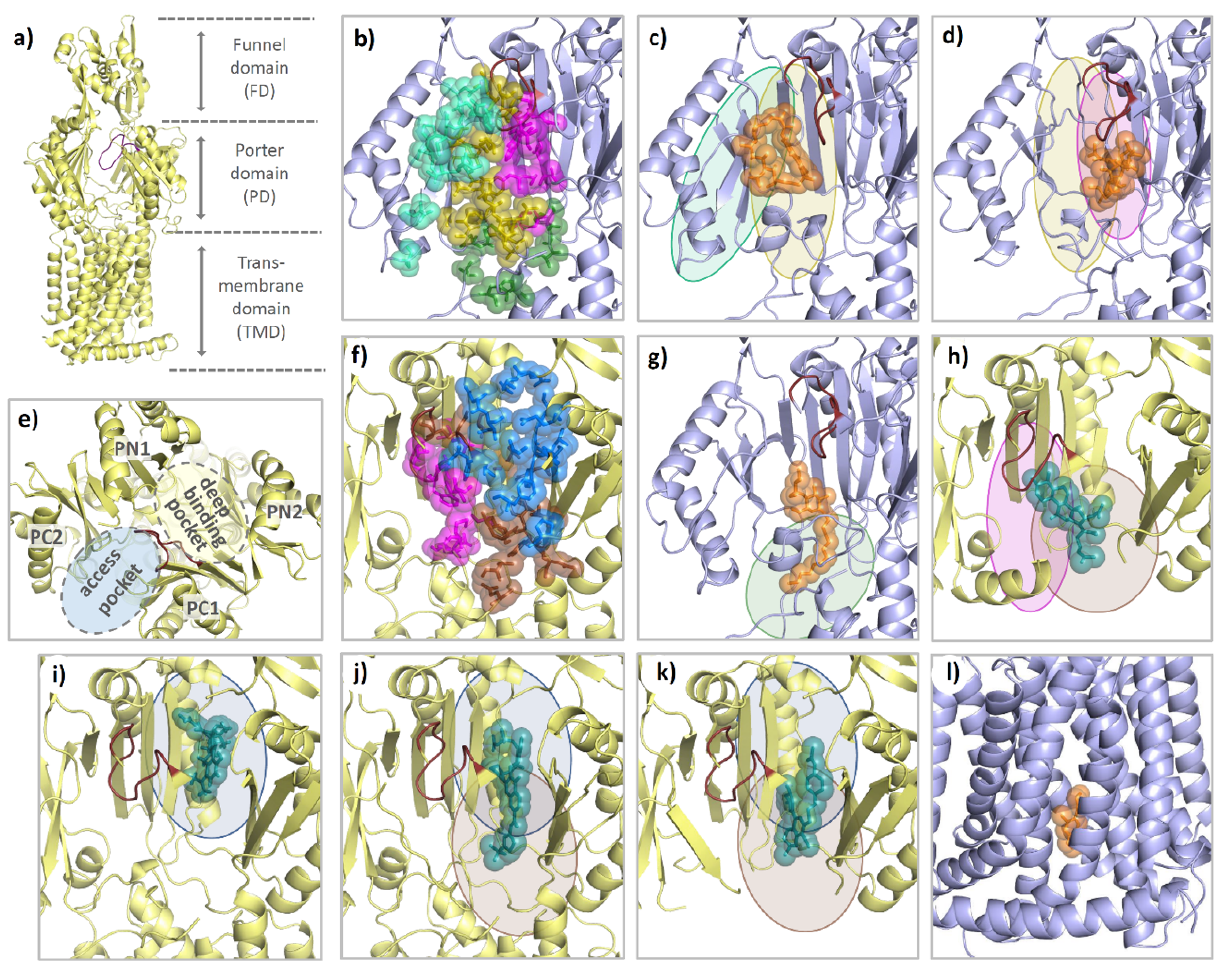
Figure 14. Comparison of the binding modes of AcrB substrates and inhibitors. Each AcrB protomer consists of a funnel domain (FD), a porter domain (PD), and a transmembrane domain (TMD) ( a ). The conformational states loose (L) and tight (T) are indicated by the color of the cartoon representation (light blue and yellow). As can be seen from a top perspective ( e ), the PD of the T protomer contains an access pocket (AP) and a deep binding pocket (DBP) that are separated by the switch loop (ruby). For the L protomer, all residues within 3.5 Å of a ligand are shown as colored spheres from a side perspective through the (removed) PC1 subdomain. Binding residues are grouped into an outer AP (cyan), an inner AP (olive), an AP–DBP interface (magenta), and channel 1 (CH1) (green) ( b ). As highlighted with the colors of the respective binding areas, the 3-formyl-rifamycin molecule (6ZOB) (shown as orange spheres, ( c )), which is stalled in front of the switch loop, predominantly binds to the outer and inner AP. Erythromycin (3AOC) ( d ), which is located underneath the switch loop, is in close contact with the inner AP and the AP-DBP interface. DDM (6ZOA) was found in CH1 of an L/T intermediate ( g ). Main residues involved in T protomer substrate/inhibitor binding were grouped into an upper DBP groove region (blue), a lower DBP cave region (brown), and the residues of the AP–DBP interface (magenta) ( f ). While the binding of substrates (shown as teal spheres) such as fusidic acid (7B8S) ( h ) and minocycline (4DX5) ( i ) appears to focus on one of the two regions (and part of the AP-DBP interface), inhibitors such as D13-9001 (3W9H) ( j ) and MBX3132 (5ENQ) ( k ) interact strongly with both cave and groove of the DBP. The inhibitor BDM88855 (7OUK) ( l ) binds to a cytoplasmic pocket within the TMD of an early L/T intermediate.